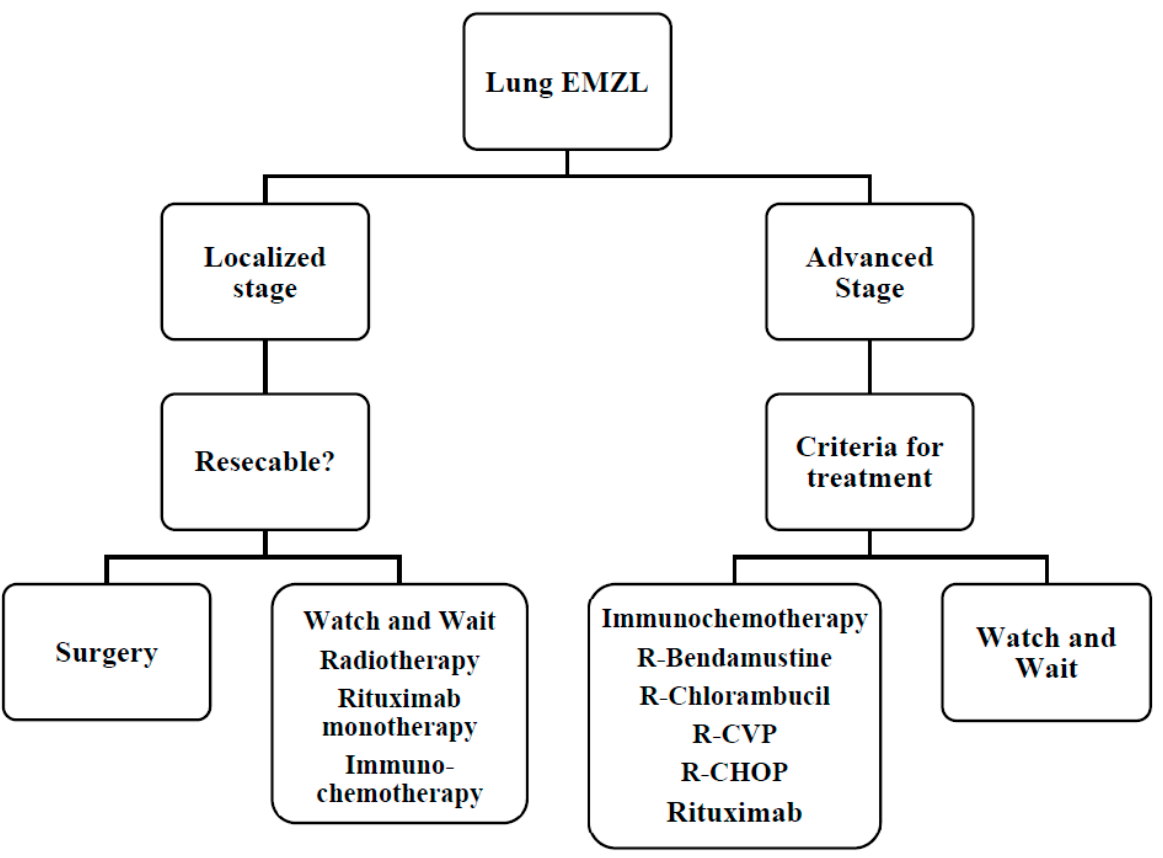
Figure 3. Therapeutic algorithm for lung EZML. R-CHOP, Rituximab, Cyclophosphamide, Vincris- tine, Adriblastine, Prednisone; R-CVP, Rituximab, Cyclophosphamide, Vincristine, Prednisone.